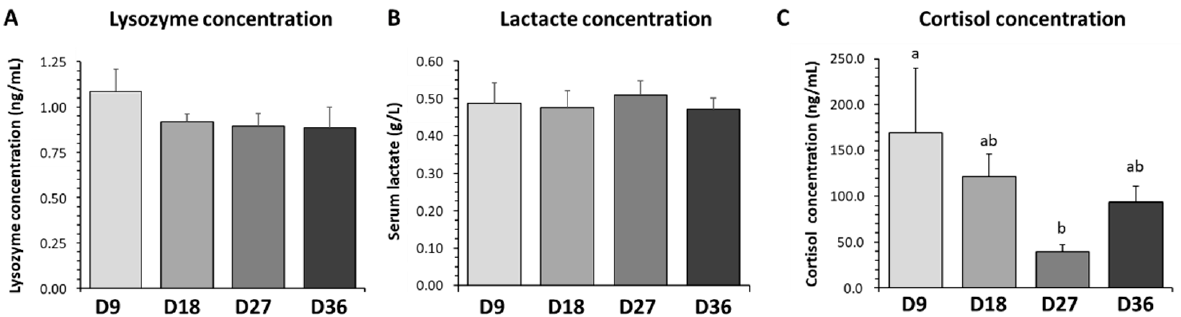
Figure 3. Lysozyme, lactate and cortisol plasma level of rainbow trout hand-fed during 12 weeks with different stocking densities. ( A ) Lysozyme (mg/mL, ( B ) Lactate (g/L) and ( C ) Cortisol level (g/L) in plasma of rainbow trout. Values are expressed as group mean ± SEM; one-way ANOVA, followed by a post hoc Tukey’s test in case of significant differences ( p < 0.05, indicated with different letters. Mean values that do no share a common letter are significantly different).